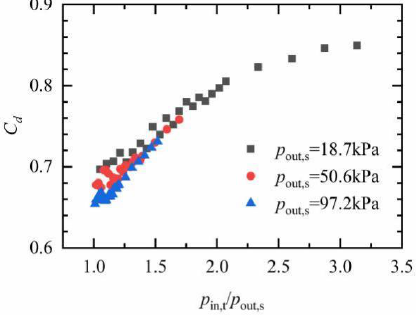
Figure 4. Discharge coefficient of the rectangular channel.